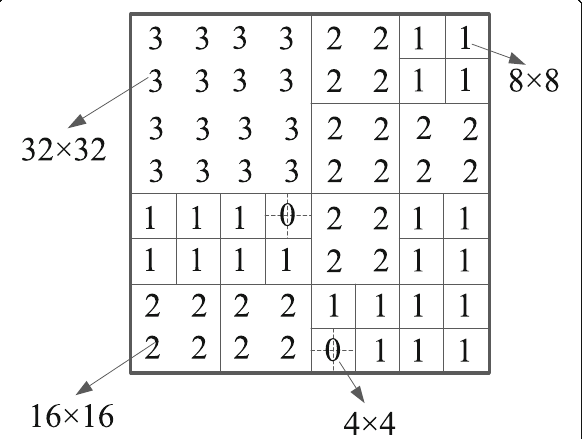
Fig. 3 Example of marking TU partition types with their labels in a 64 × 64